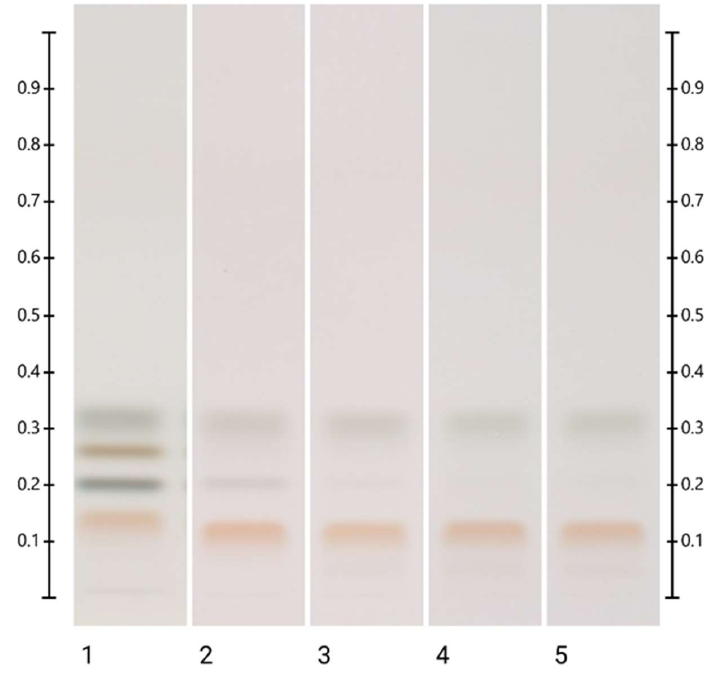
Table 3. Fructose and glucose content in different honeys.